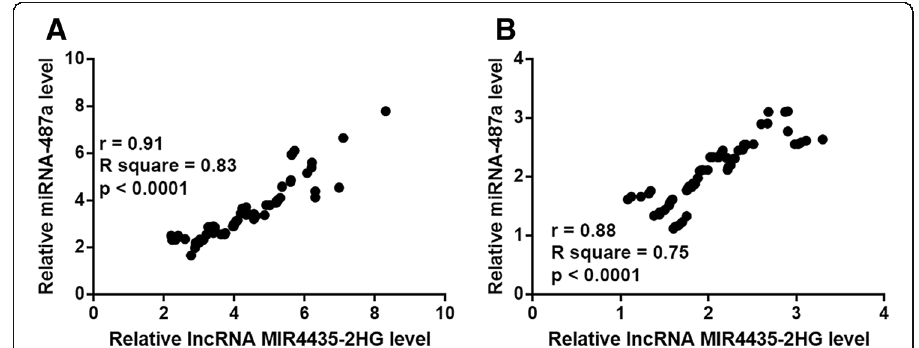
Fig. 3 MIR4435-2HG and miRNA-487a expression levels were positively correlated in tumor tissues and adjacent healthy tissues. Pearson ’ s correlation coefficient showed that MIR4435-2HG and miRNA-487a expression levels were positively correlated in tumor tissues ( a ) and adjacent healthy tissues ( b ) from